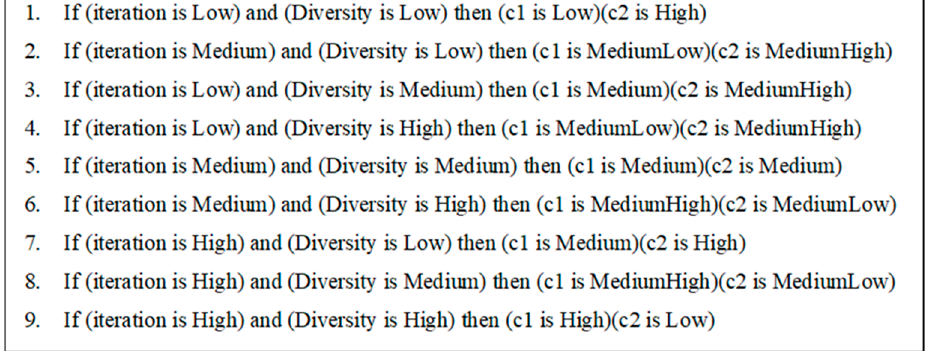
Figure 5. Fuzzy rules proposed for the second fuzzy system.